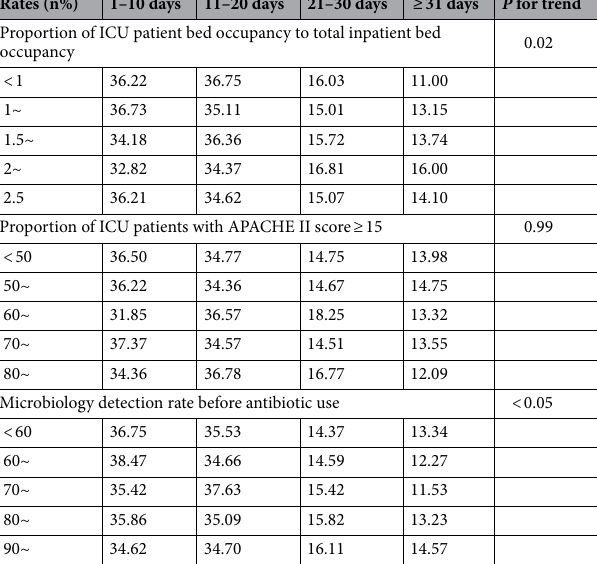
Table 2. Relationship between quality control indicators and hospital stay. ICU, intensive care unit; APACHE, acute physiology and chronic health evaluation.